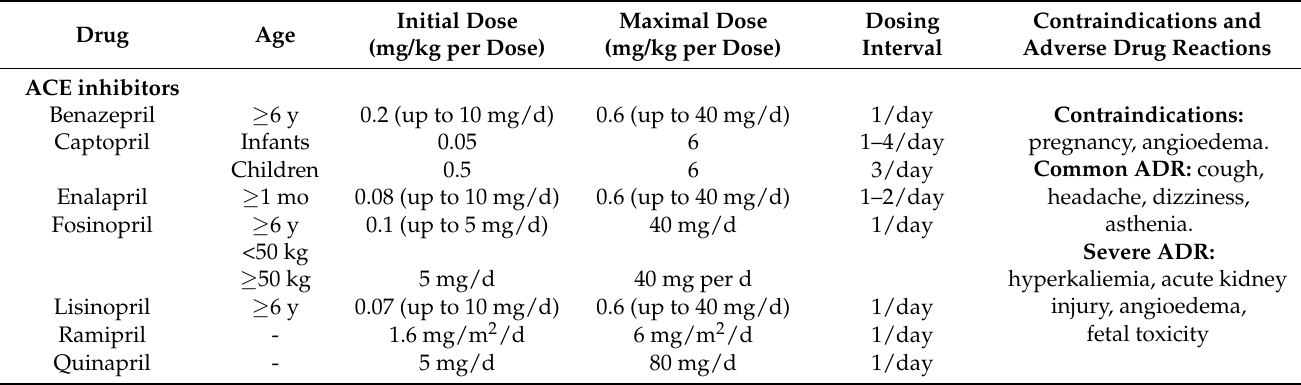
Table 2. Antihypertensive drugs: age and dosing recommendations, contraindications, and adverse drug